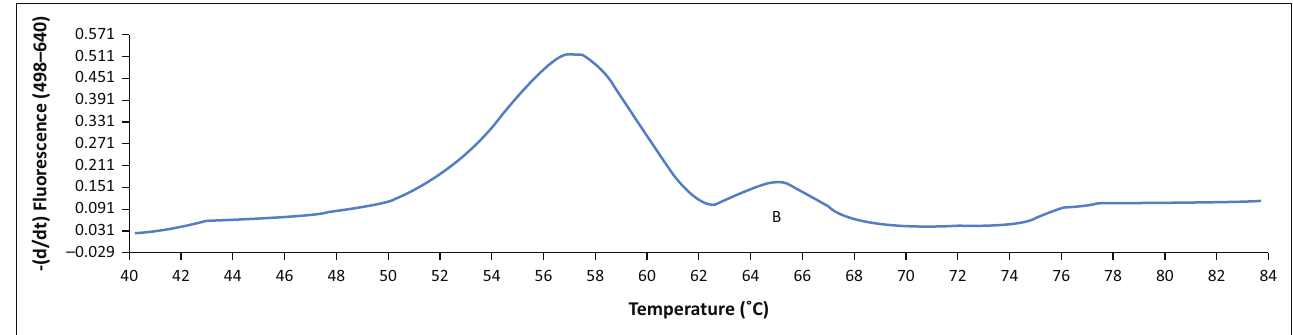
– peak A (subtypes other than 1d – 55.7 °C) and stx 1